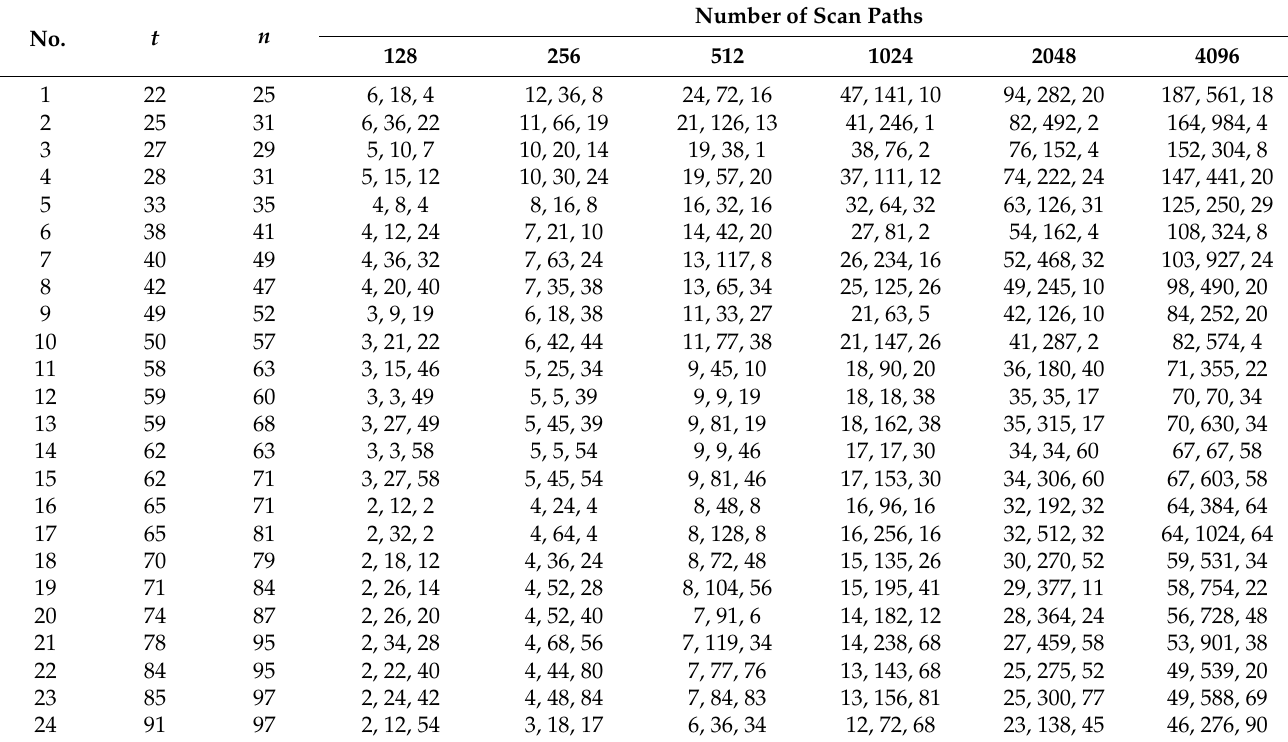
Table 8. Supplementary details on the structures of test pattern generators of the DT-LFSR-TPG type.